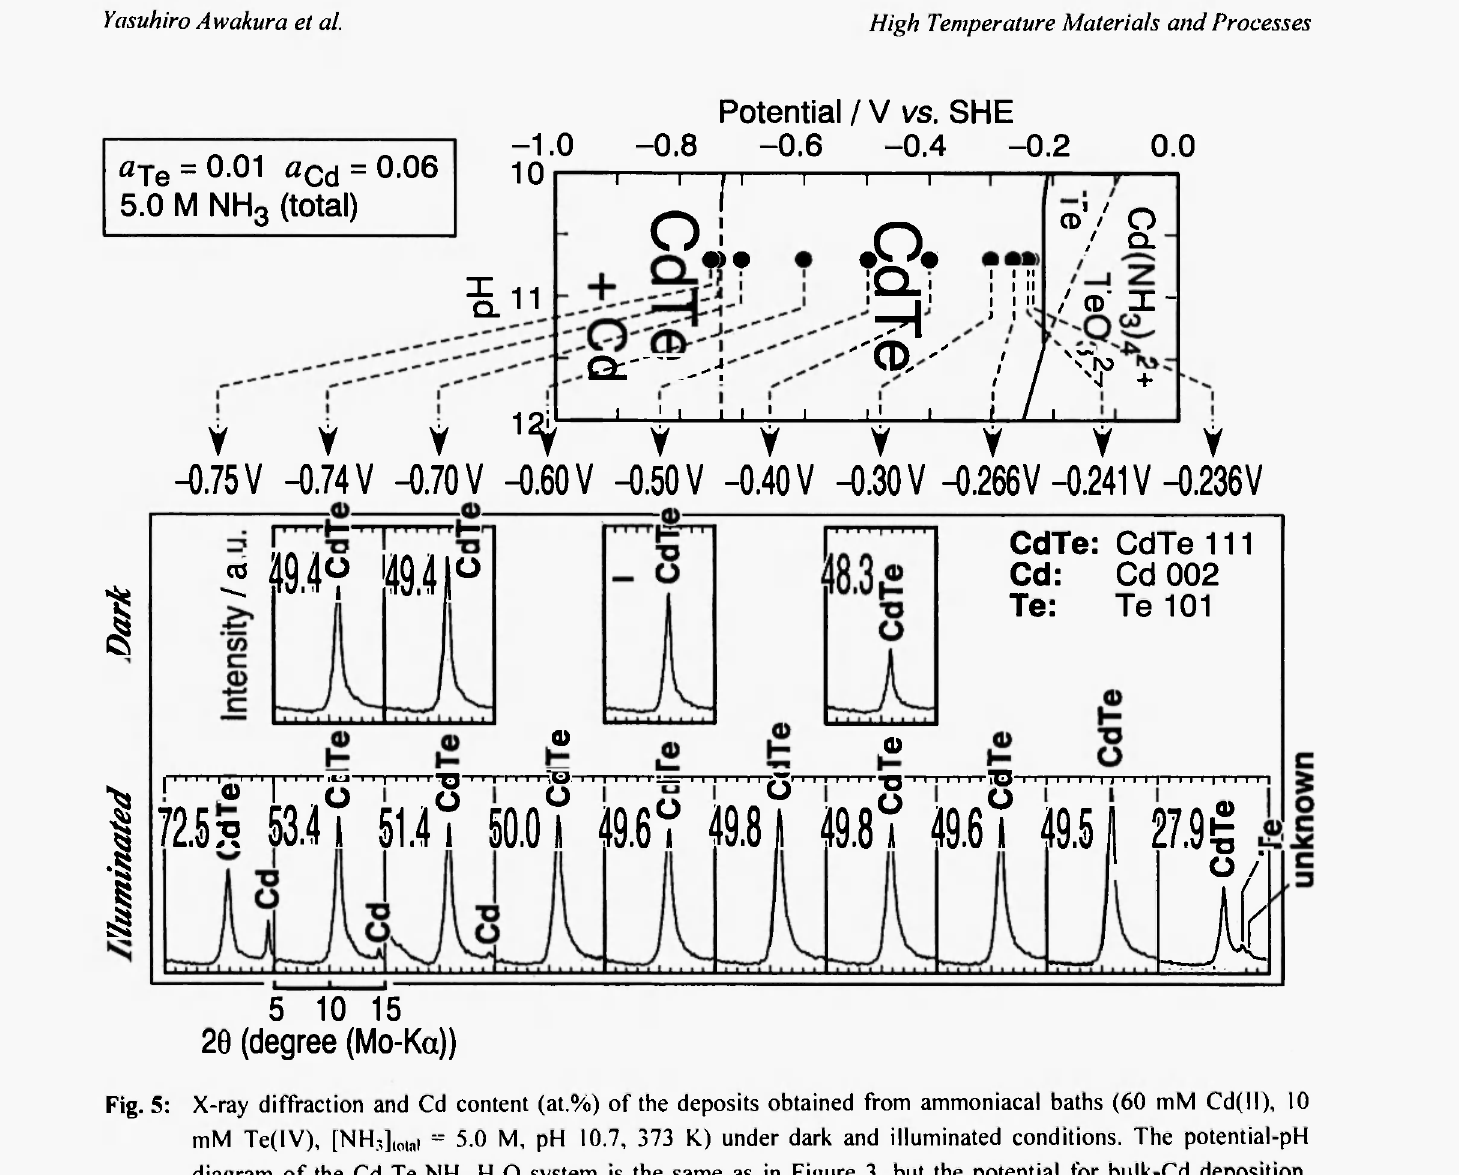
Fig. 5: X-ray diffraction and Cd content (at.%) of the deposits obtained from ammoniacal baths (60 mM Cd(ll), 10 mM Te(IV), fNH 3 ], ota i = 5.0 M, pH 10.7, 373 K) under dark and illuminated conditions. The potential-pH diagram of the Cd-Te-NH r H 2 0 system is the same as in Figure 3, but the potential for bulk-Cd deposition, E< d/cd(ii)< is